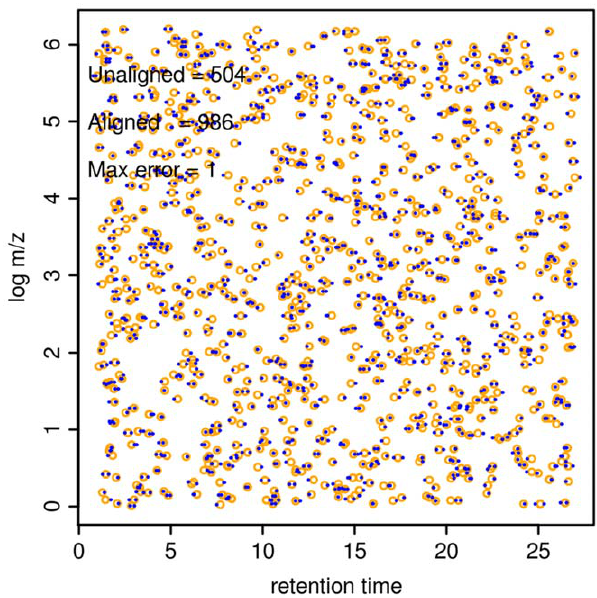
Figure 10. Distributions of features and TSMs in Toy A data. The circles represent TSMs and the dots represent the features in two maps. The two axes represent retention time and log m/z (or mass). The three lines of texts in the plots represent, in order; a ) the number of features (non-aligned TSMs), which should not be aligned; b ) the number of features (aligned TSMs), which should be aligned; c ) maximum allowed noise level. A value of "1" means that noise was added to features at the maximum 100% of the pre-defined resolution, i.e. 0.3 min for retention time and 10 ppm for mass.